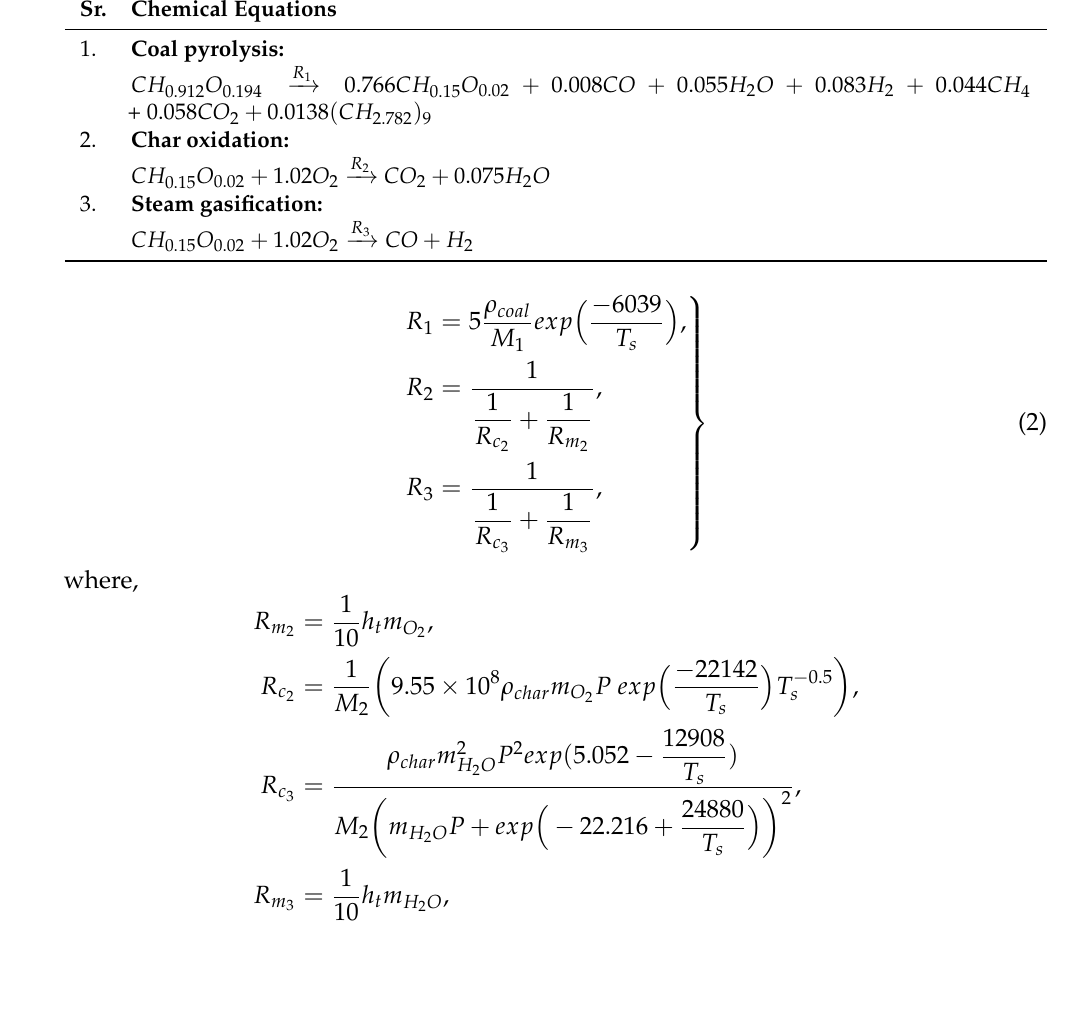
Table 3. Chemical reactions in